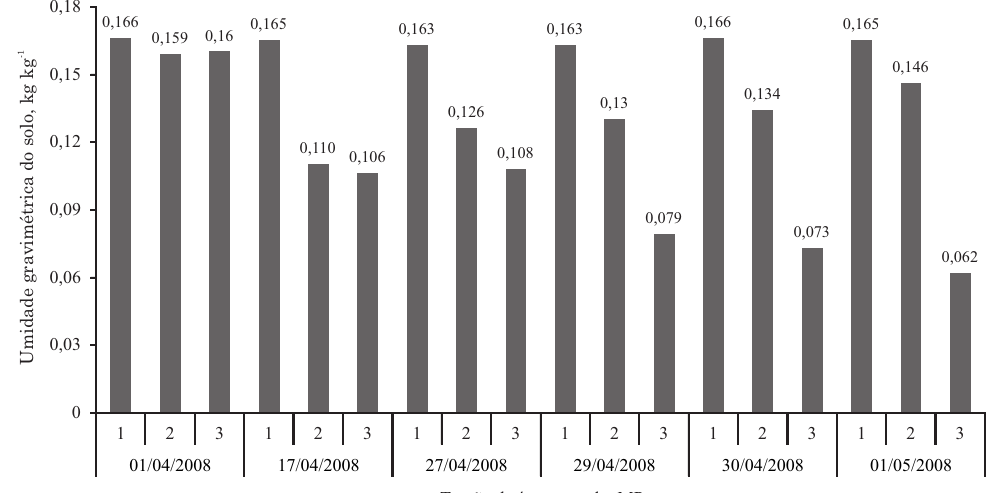
Figura 1. Umidade gravimétrica do solo durante a condução do experimento em função dos níveis de tensão de água no solo (1 = 0,01 MPa; 2 = 0,03 MPa; e 3 = 0,1 Quadro 2. Umidade gravimétrica do solo no final do experimento em razão dos níveis de tensão de água no solo e das fontes e doses de B aplicadas